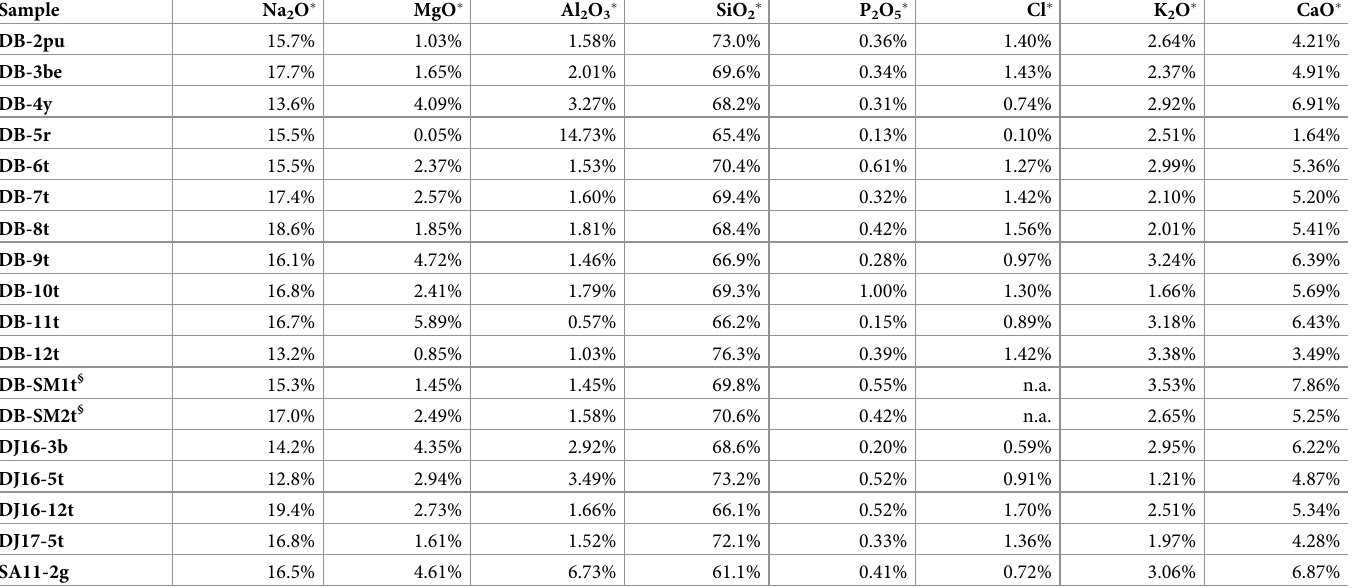
Table 2. Reduced composition ( � ) of the analysed glass beads by